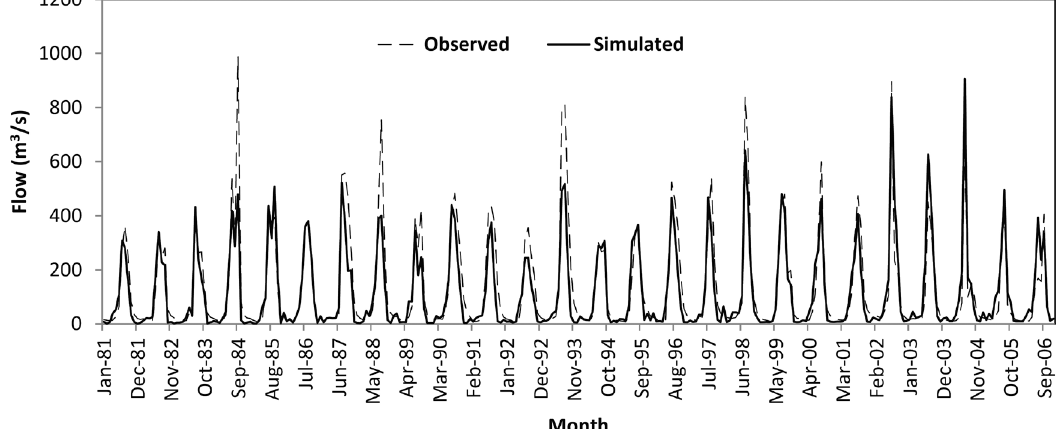
Fig. 2 Observed and simulated hydrographs at the Pandhera Dobhan gauging station.